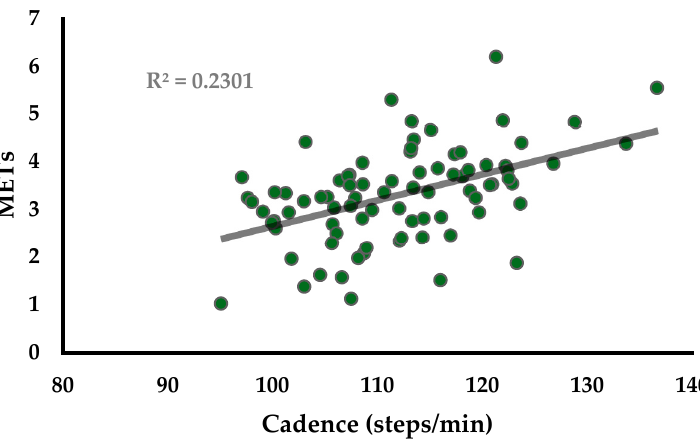
Figure 2. Scatterplot showing relationship between METs and Cadence (steps/min) for n = 29 pregnant women at three walking intensities (r = 0.48).